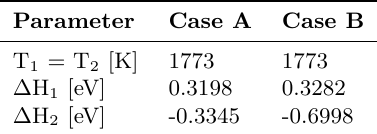
Table 1. Parameters for the enhanced diffusivity model derived for Cr-doped fuel [7].